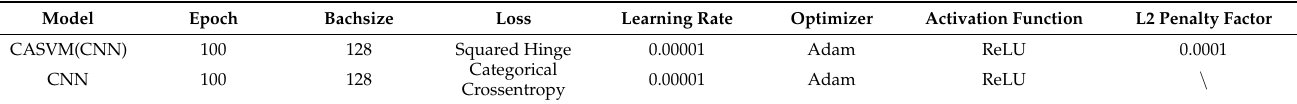
Table 6. Main training parameters of CASVM.